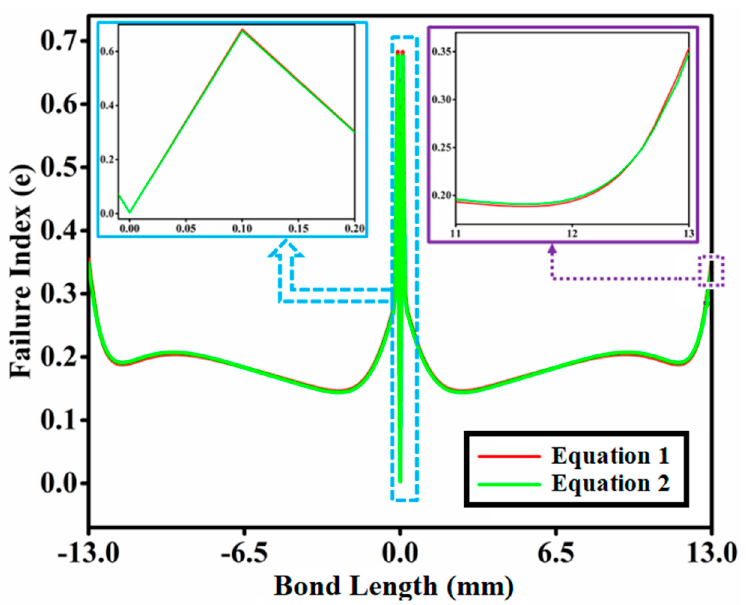
Figure 4. Variation of the failure index (e) along the length of the bond (Equations (1) and (2)).